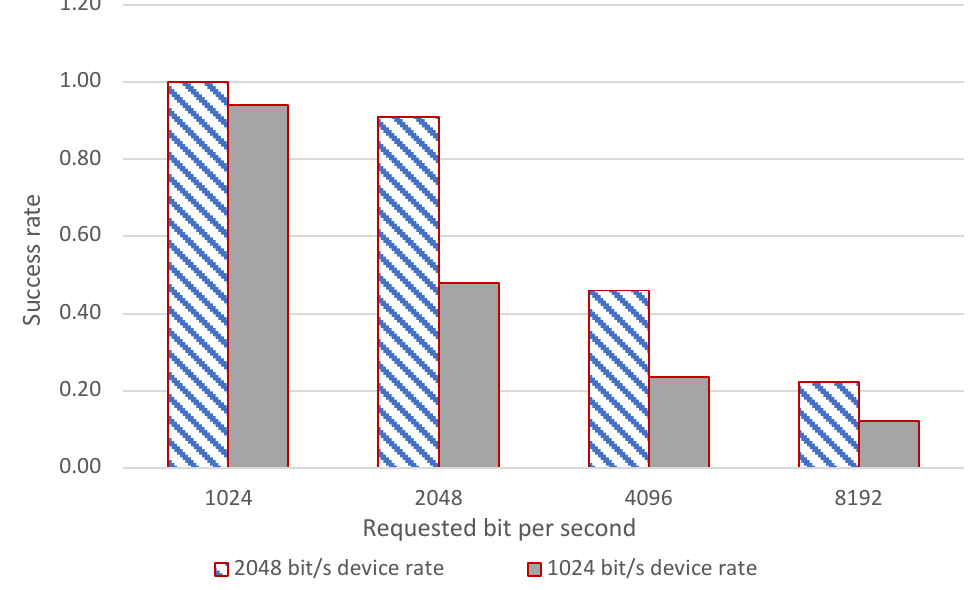
Figure 9. Success rate of the getKey requests to the QKS varying the underlying exchange rate.